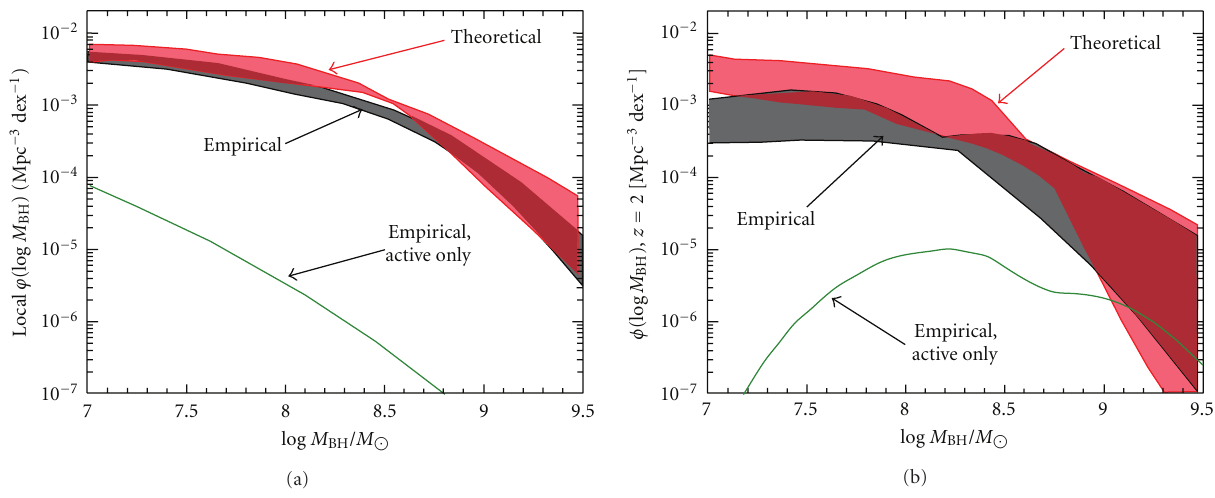
Figure 7: Comparison of empirical estimates of the BHMF (grey shaded region) with BHMFs predicted by theoretical models for SMBH formationand growth (red shaded region), in both the local universe (a) and at z = 2 (b). Also shownare the estimated BHMFs of broad-line AGN only (solid green line), from Schulze and Wisotzki [121] (a) and Kelly et al. [115] (b). The empirical estimates of the BHMF are those shown in Figures 3 and 4, while the theoretical estimates are those shown in Figure 6. The shaded regions define the spread in the estimates and models and may be considered to be a crude estimate of their uncertainty. In general, the theoretical number densities are consistent with the empirical ones to within a factor of a